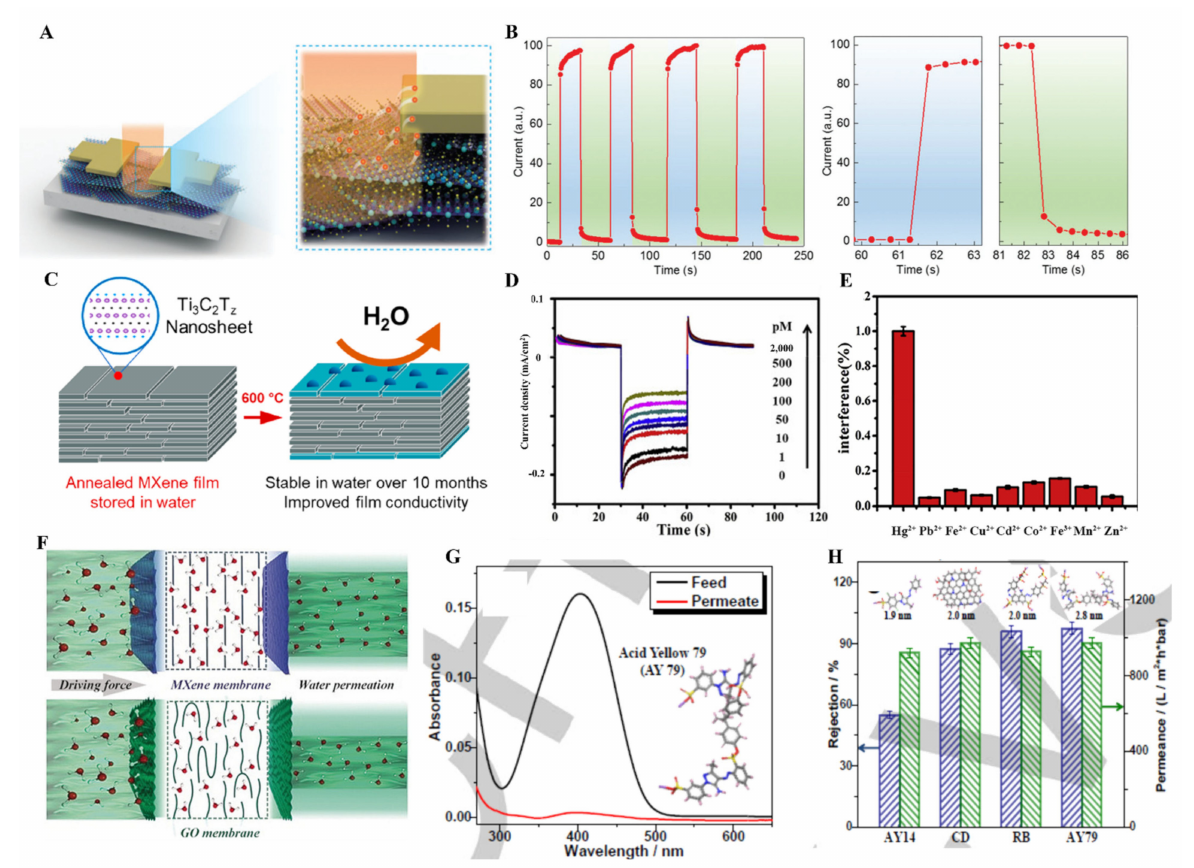
Figure 15. ( A ) Schematics of plasmon-assisted hot electron migration toward gold electrode in Mo 2 CT x -based photodetector, (reproduced with permission [51]. Copyright 2019, Wiley-VCH); ( B ) Increase and decrease the cycle of photocurrent upon switching the light ON and OFF in the case of Mo 2 CT x thin film-based photodetector (reproduced with permission [51]. Copyright 2019, Wiley-VCH); ( C ) Schematic of Ti 3 C 2 T x MXene thin films annealed at 600 ◦ C and stored in